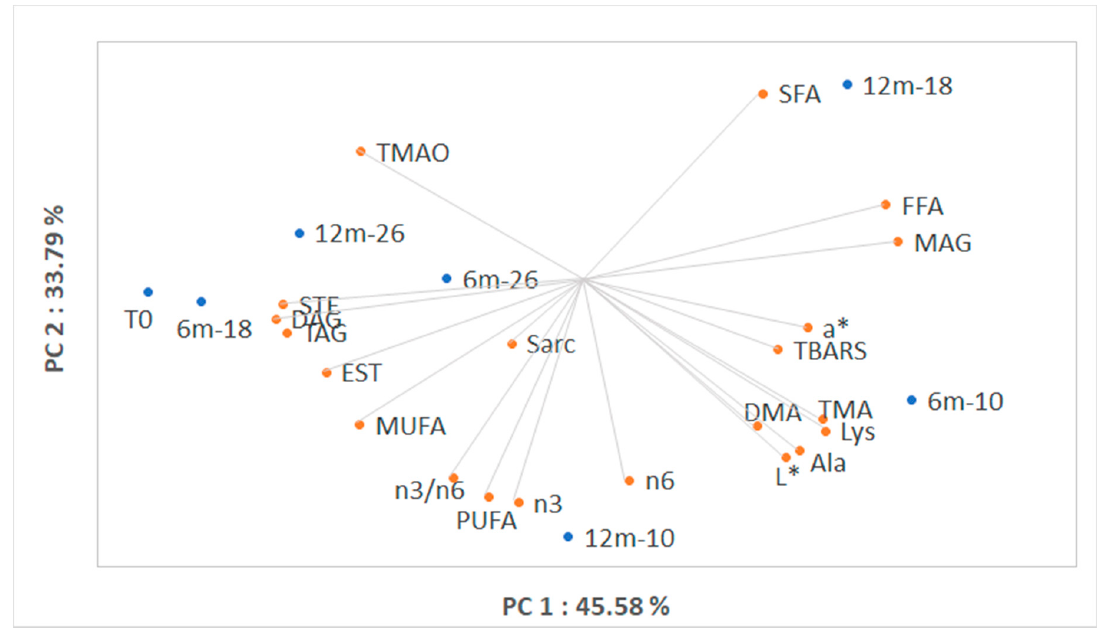
Figure 4. Scores and loadings biplot of data obtained from samples at the beginning of the storage (0), after 6 months (6 m) and 12 months (12 m) of storage at − 10, − 18 and − 26 °C. PC, Principal Component; a*, red index; Ala, alanine; DAG, diacylglycerols; Dimethylamine, DMA; EST, esterified sterols; FFA, free fatty acids; L*, luminosity; Lys, lysine; MAG, monoacylglycerols; MUFA, monounsaturated fatty acids; PUFA, polyunsaturated fatty acids; Sar, sarcosine; SFA, saturated fatty acids; TAG, triacylglycerols; STE, sterols; TBARs, thiobarbituric acid reactive substances; TMA, trimethylamine ‐ N; TMA ‐ O, trimethylamine ‐ O.